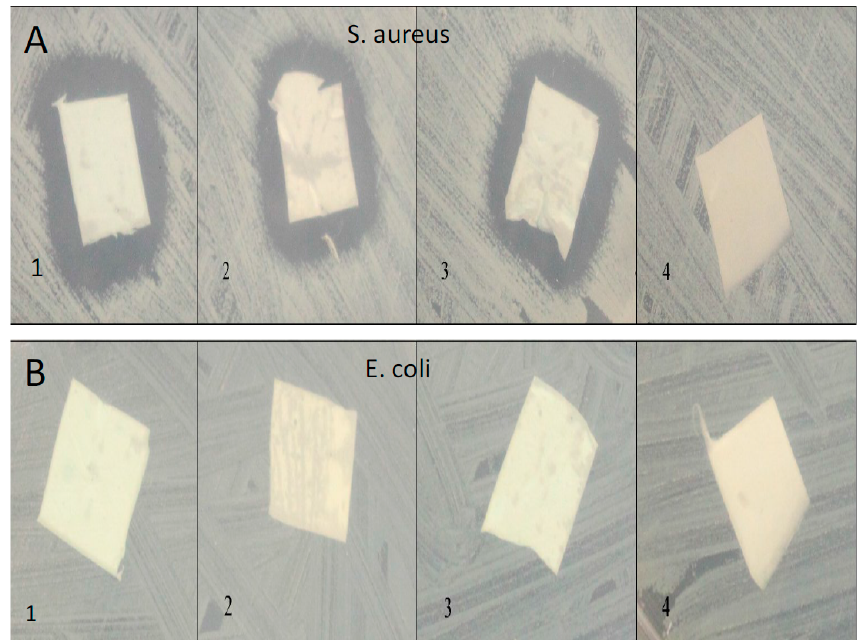
Figure 9. ( A ) S. aureus and ( B ) E. coli confluent cultures with scaffolds added and observed